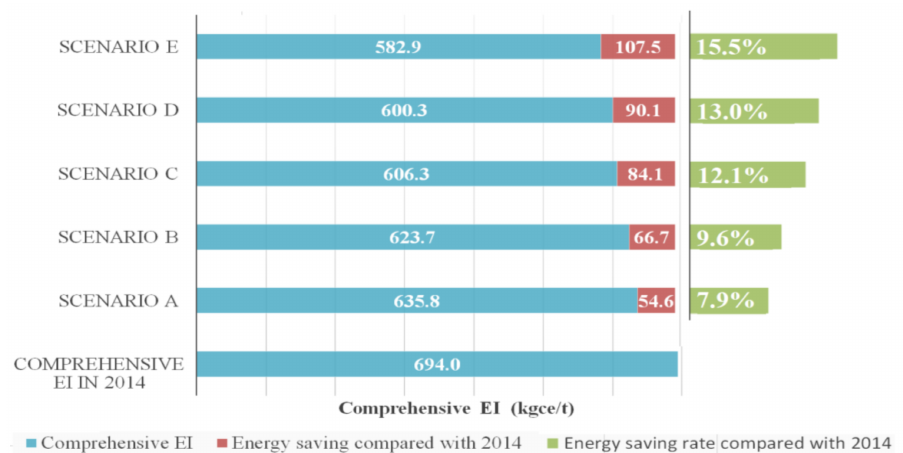
Figure 4. Energy saving potential in different scenarios (considering coal consumption of power generation).